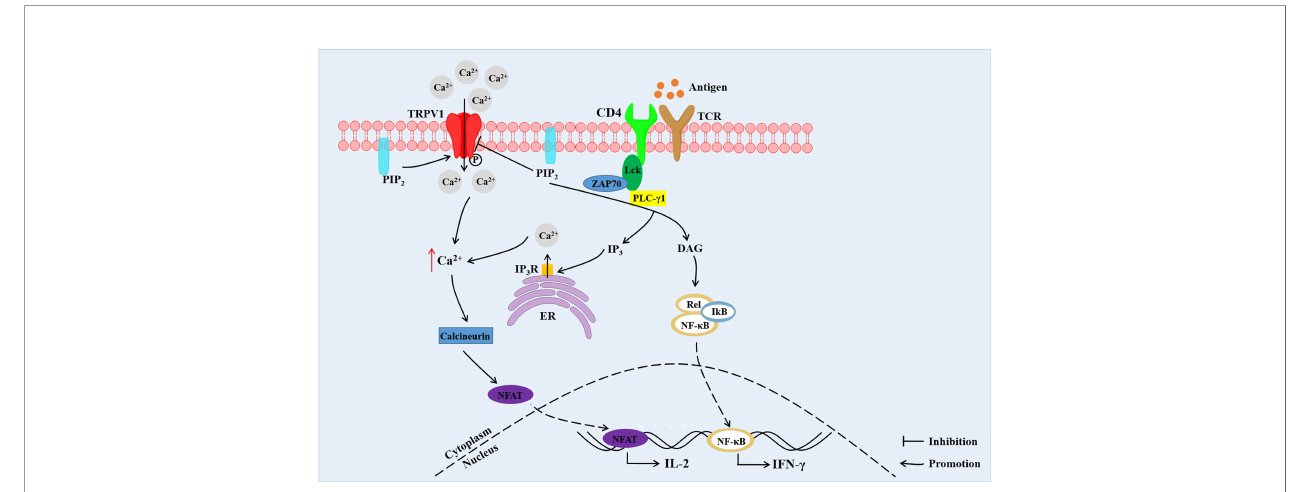
FIGURE 2 | The TCR signals and TRPV1-mediated increase in Ca 2+ concentration and downstream Ca 2+ -dependent signaling in CD4 + T cells. TRPV1 is bound with CD4 and Lck. TRPV1 mediates Ca 2+ in fl ux, and the tyrosine of TRPV1 is phosphorylated by Lck. PIP 2 located in both lea fl ets suppresses the activation of TRPV1. Hydrolysis of PIP 2 into DAG and IP 3 by PLC- g 1 leads to relieving of PIP 2 -mediated inhibition of TRPV1. Besides, IP 3 binds to IP 3 R on ER contributing to the release of Ca 2+ from intracellular Ca 2+ store. The increased Ca 2+ concentration promotes migration of NFAT into the nucleus, inducing the expression of IL-2. DAG promotes the entry of NF- k B into the nucleus, resulting in IFN- g expression. PIP 2 , phosphatidylinositol-4,5-bisphosphate; PLC- g 1, phospholipase C gamma 1; IP 3 , inositol 1,4,5- trisphosphate; DAG, diacylglycerol; IP 3 R, IP 3 receptor; ER, endoplasmic reticulum; NFAT, nuclear factor of activated T-cells; NF- k B, nuclear factor kappa binding